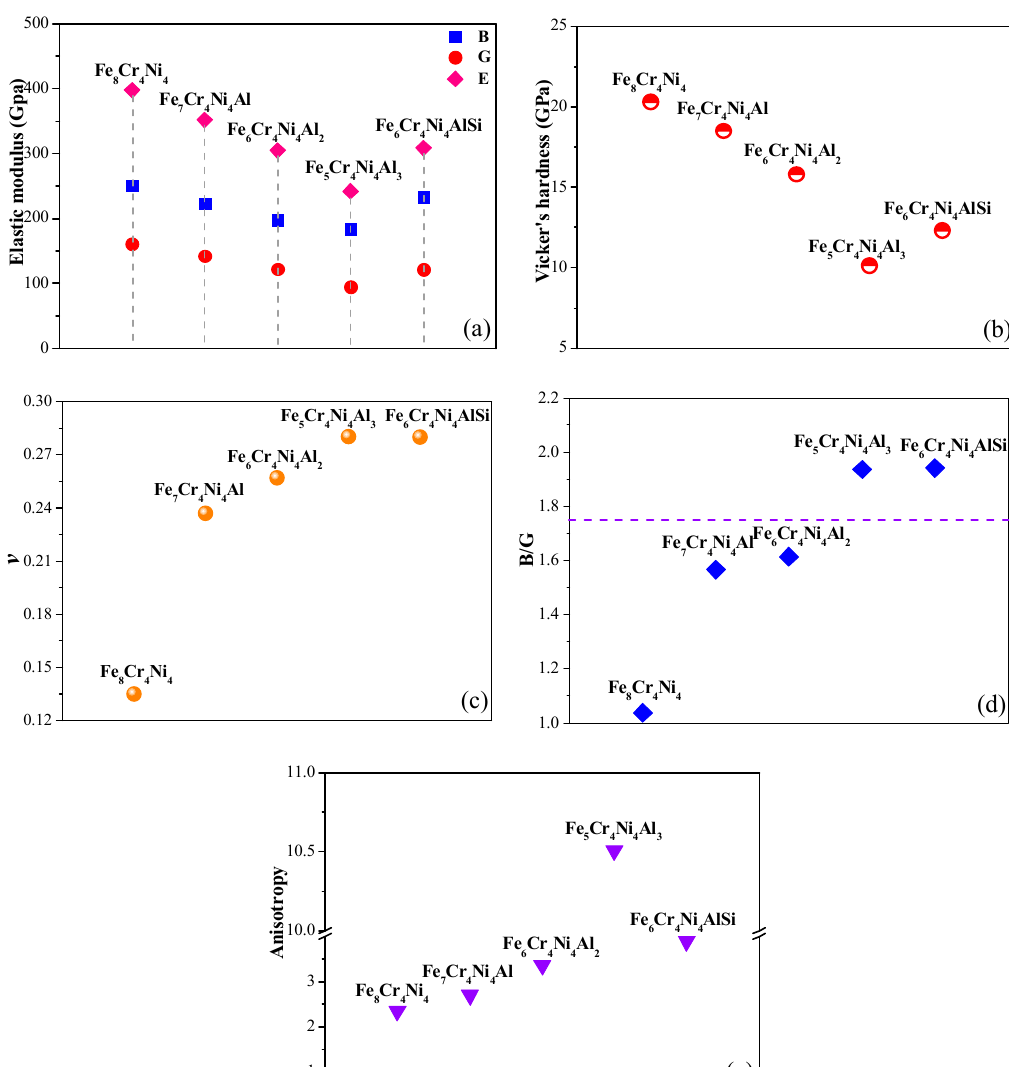
Figure 8. Calculated mechanical properties of different systems: ( a ) The bulk modulus (B), shear modulus (G), and Young’s modulus (E); ( b ) the Vicker’s hardness; ( c ) the Poisson’s ratio values; ( d ) the B/G ratio values; ( e ) the Zener’s anisotropy parameter A Z .